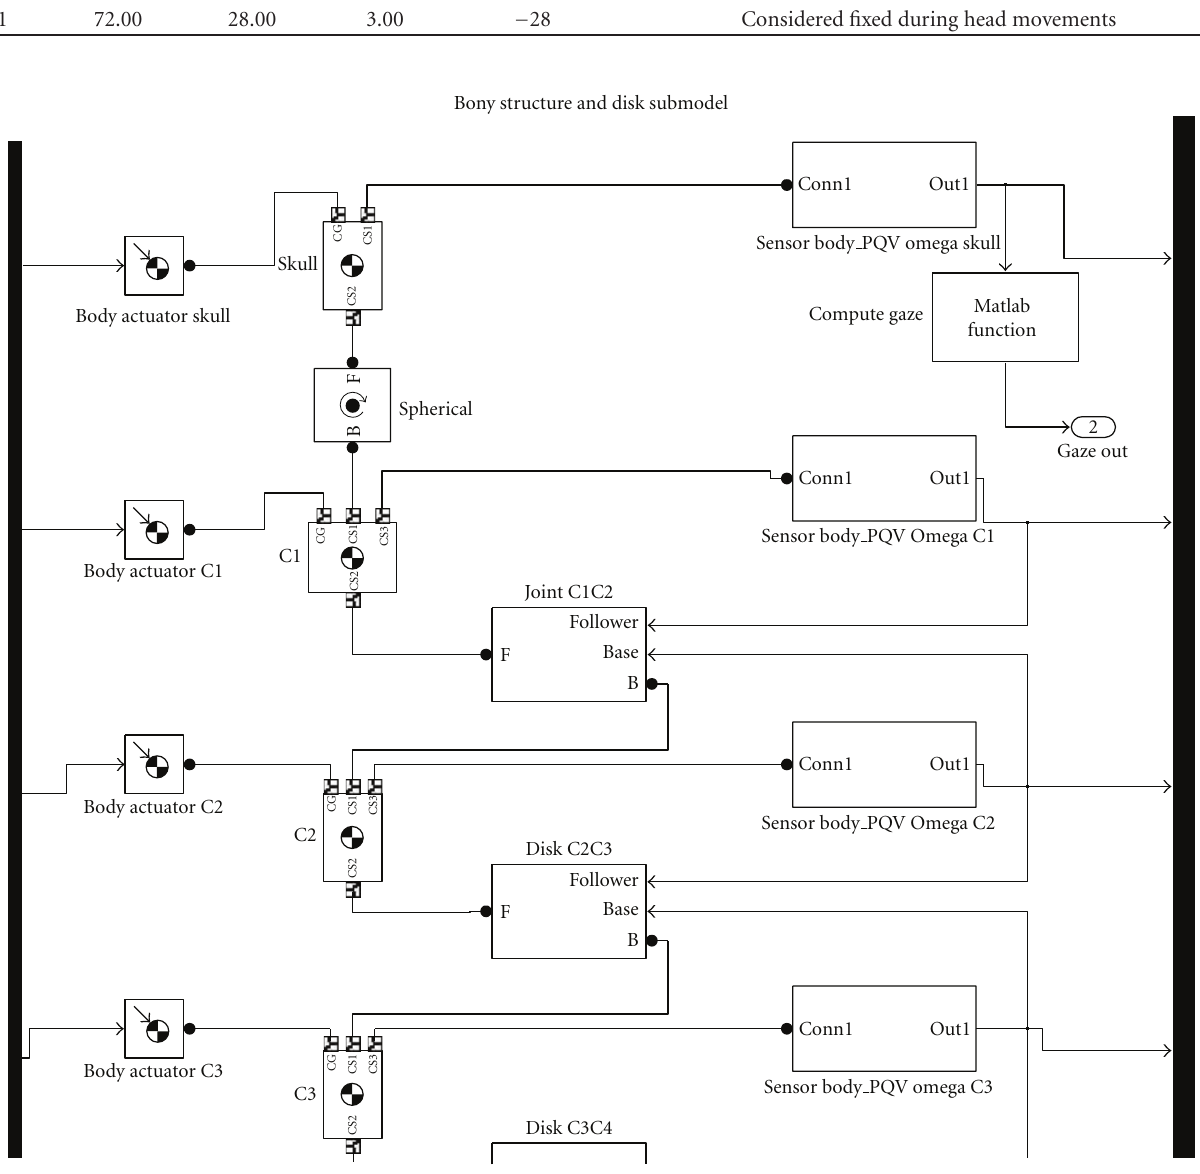
Figure 5: Detail of the submodel for the bony structures and intervertebral disks in Simulink-SimMechanics. Blocks skull, C1, C2, and C3 are rigid bodies receiving their corresponding net force and moment from muscles, ligaments, and facet joints through body actuator interfaces (at the left). The joint between the occiput and C1 is represented as a spherical joint in SimMechanics and the di ff erent disks are represented as bushing joints in SimMechanics (see Figure